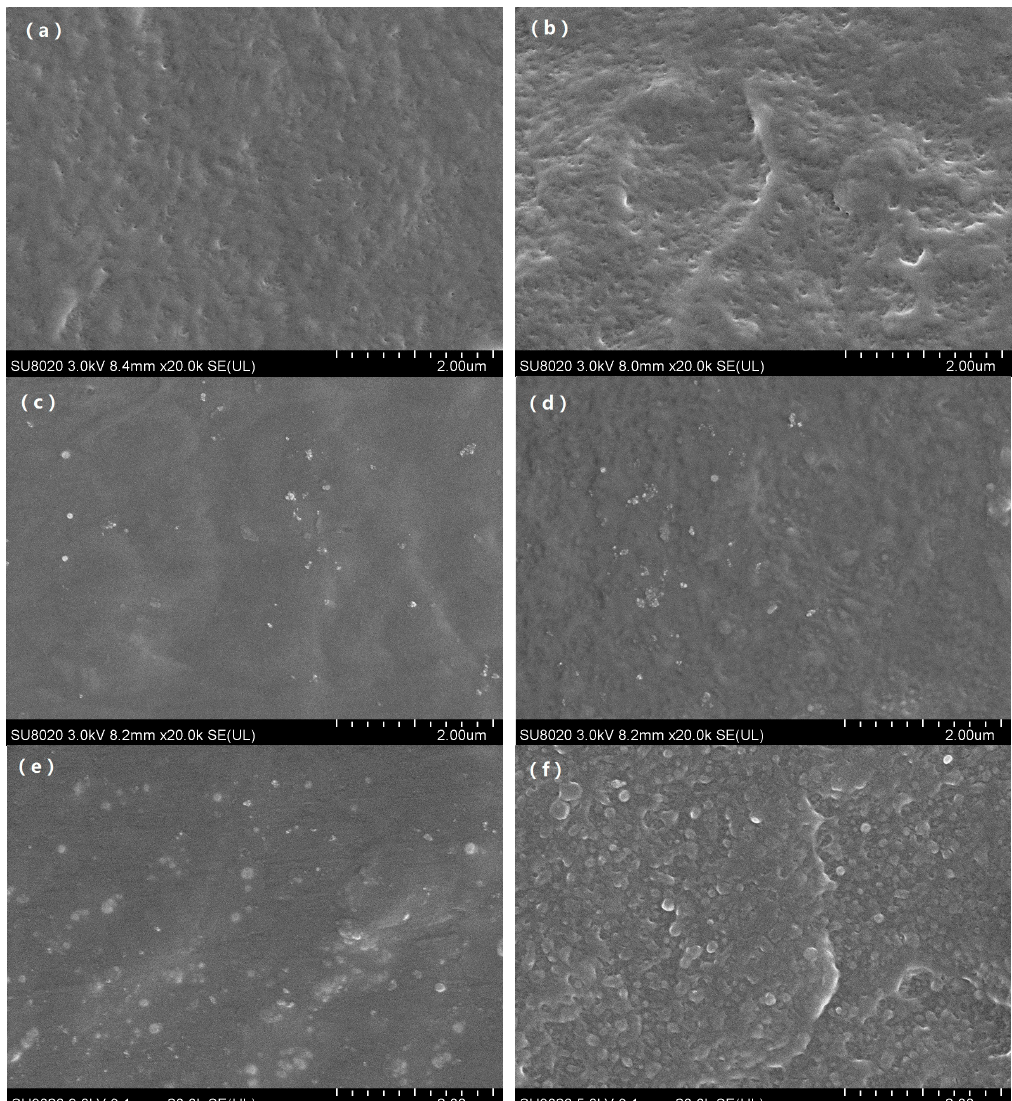
Figure 1. SEM image of pure low-density polyethylene (LDPE) pure 1 ( a ), pure 4 ( b ) and zeolite / LDPE nanocomposites NaY1-1 ( c ), NaY1-4 ( d ), NaY3-1 ( e ), NaY3-4 ( f